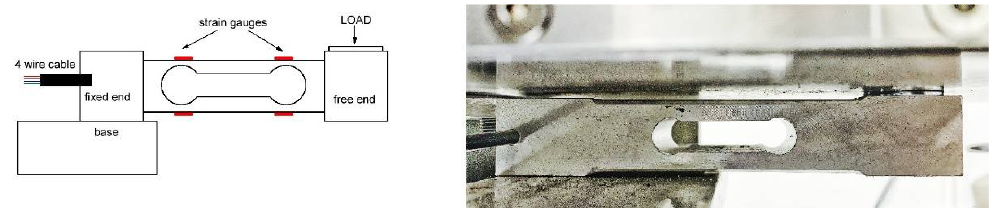
Figure 1. A load cell representation ( left ) and the load cell used in our device ( right ).